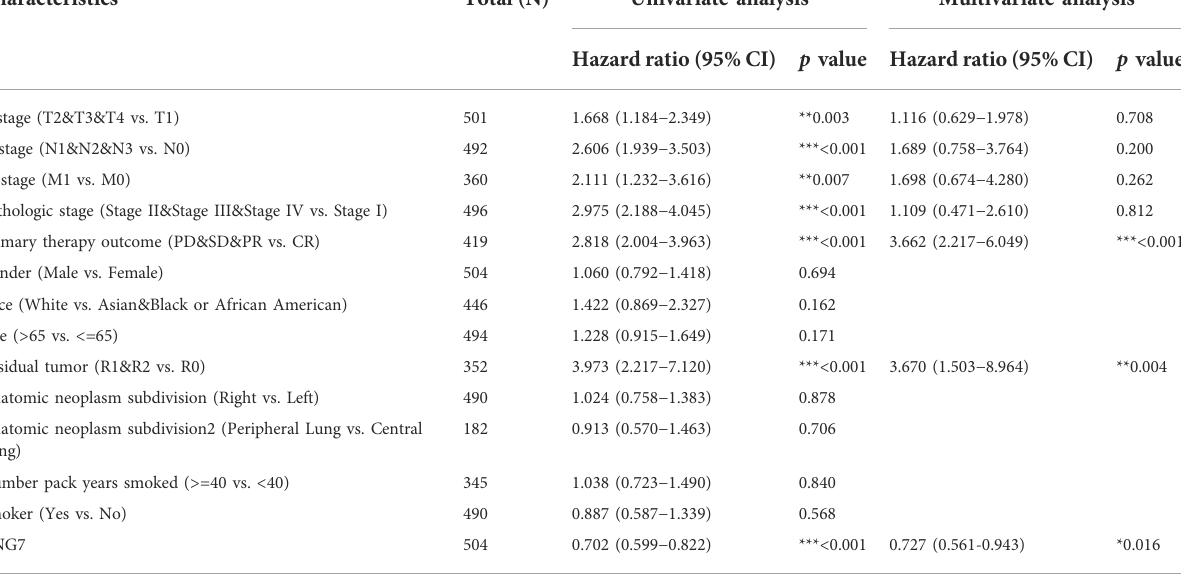
TABLE 2 Univariate analysis and multivariate analysis of the correlation between clinicopathological characteristics and OS in LUAD.